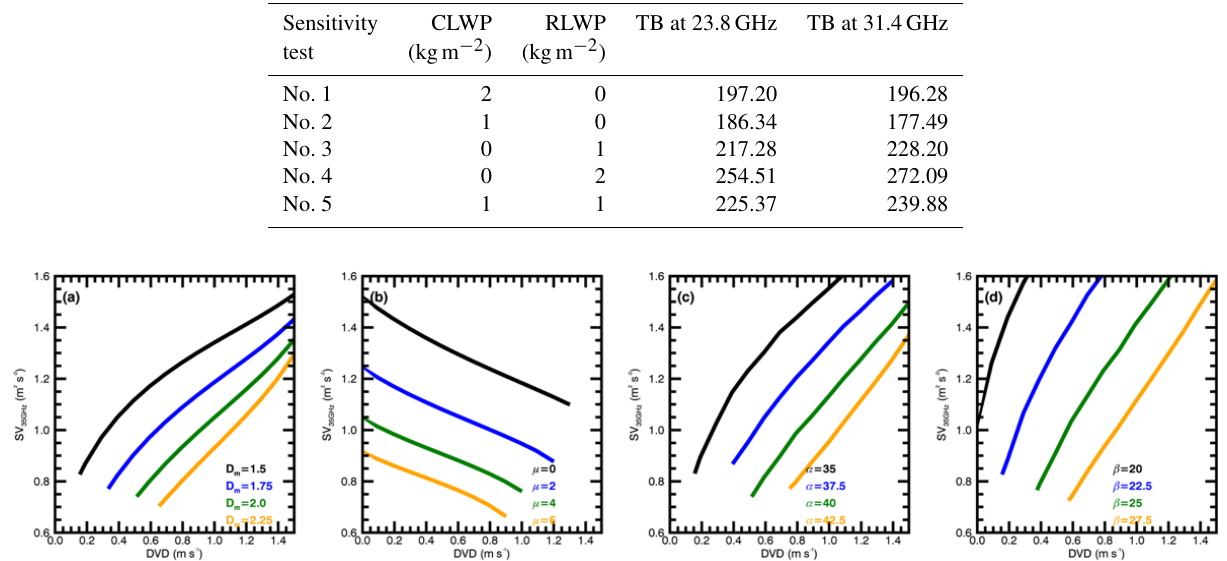
Figure A1. Comparisons of (a) mass-weighted mean diameter D m (mm), (b) shape parameter µ , (c) parameter α = 10 log( Z 3GHz / RLWC), and (d) parameter β = 10 log( Z 3GHz / RR) calculated as functions of Doppler velocity difference (DVD) and spectrum variance at 35GHz (SV 35GHz ). Note that the units of RLWC and RR are grams per cubic meter (gm − 3 ) and millimeters per hour (mmh − 1